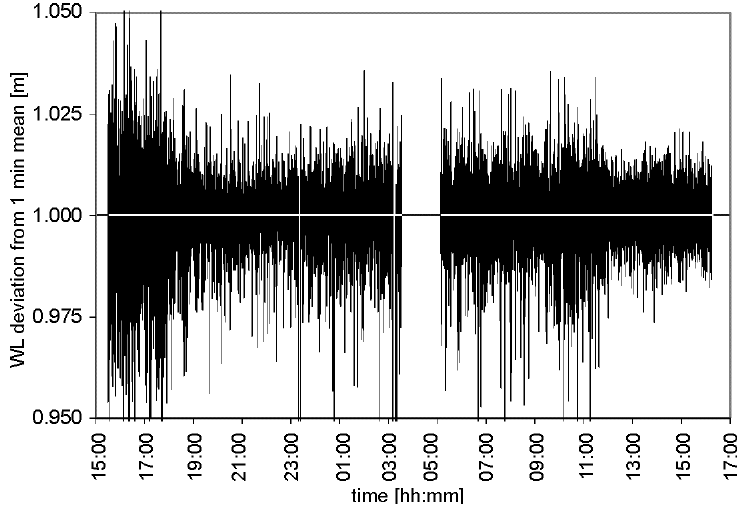
Figure 3. Wave intensity shown as deviation of the water depth (WL: water depth).